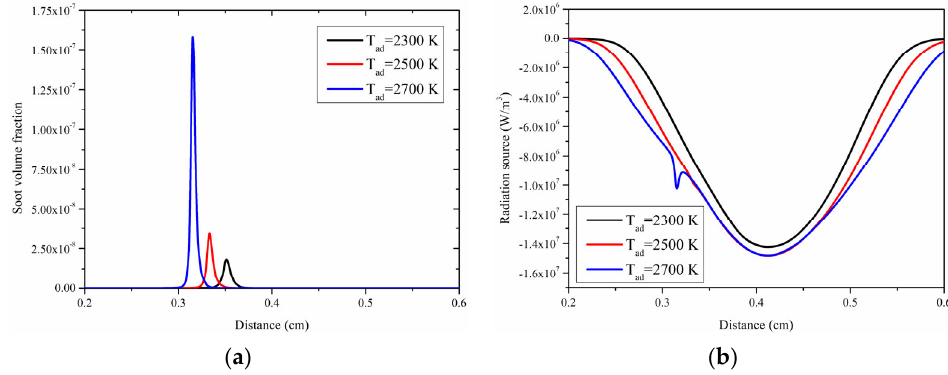
Figure 10. The distributions of SVF ( a ) and radiation source ( b ) in cases 1.3, 2.2, and 3.1.